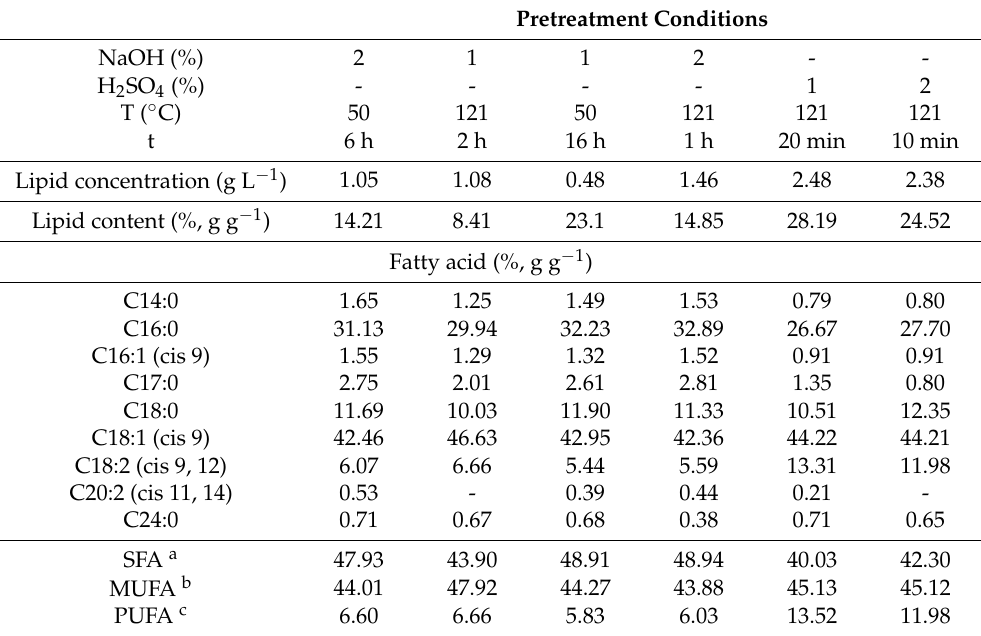
Table 4. Cultivation of T. oleaginosus on filtrate of lignocellulose slurry obtained after pretreatment. The concentration of lipids, lipid content in solid residue and fatty acid composition of extracted lipids were determined at the end of